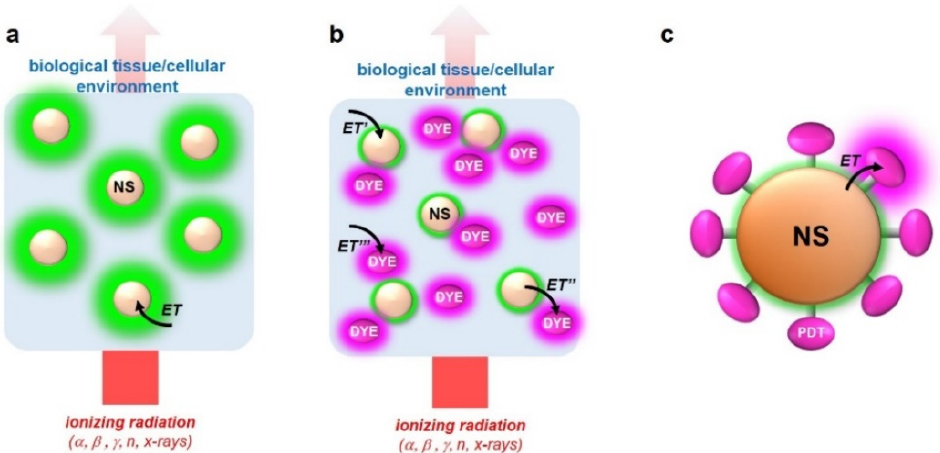
Figure 4. Sketch of the working principle of X-ray activated X-PDT. ( a ) Inorganic nanoscintillators (NS) can be easily embedded in a biological surrounding. ( b ) The NS scintillation luminescence can be exploited to excite a secondary photoactive moiety (dye) by energy transfer (ET). ( c ) Multicomponent hybrid nanosystems can be fabricated by decorating the NS surfaces with specific photoactive functionalities, for example PDT agents, whose action is sensitized by ET from the NS that mainly interacts with the ionizing radiation.